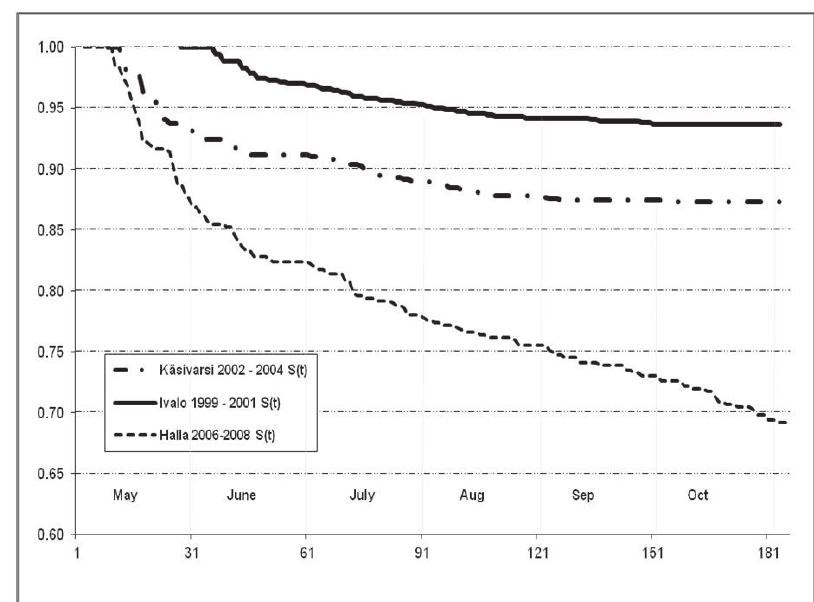
Fig. 2. Total survival curves for radio-collared reindeer calves in Ivalo (in 1999- 2001), Käsivarsi (in 2002-04) and Halla (in 2006-08) reindeer-herding cooper- atives, expressed as days after 1 May (day 1). (Mortality (M) = 1 –